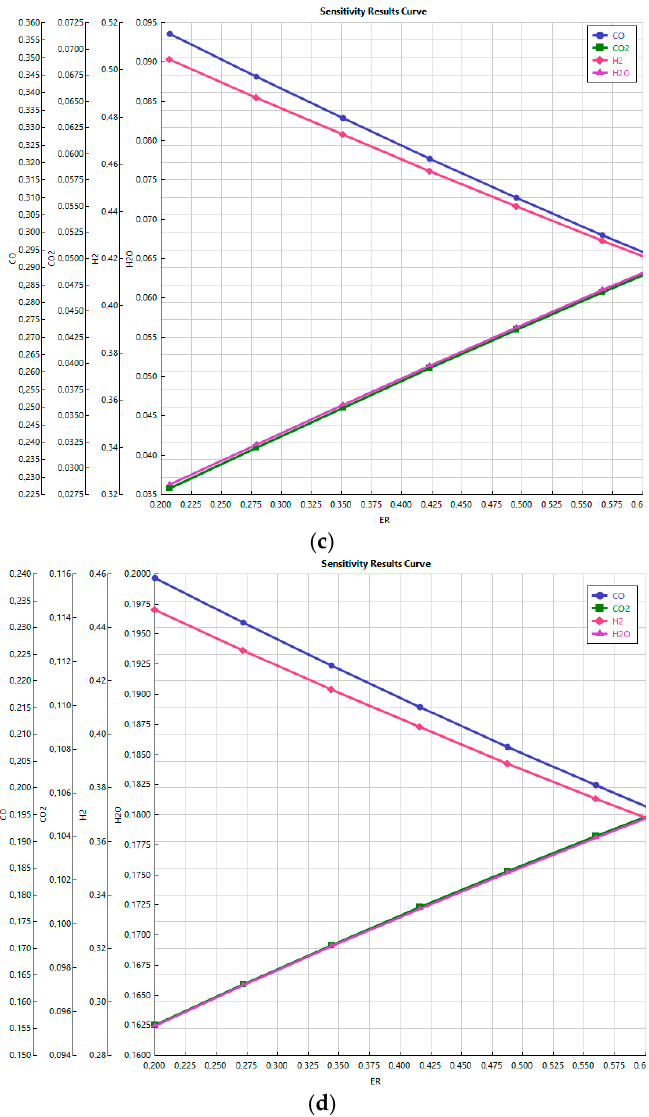
Figure 5. ( a ) Effect of air equivalent ratio on the syngas composition from hazelnut shells. ( b ) Effect of air equivalent ratio on the syngas composition from olive pruning. ( c ) Effect of air equivalent ratio on the syngas composition from olive pomace. ( d ) Effect of air equivalent ratio on the syngas composition from wheat straw.